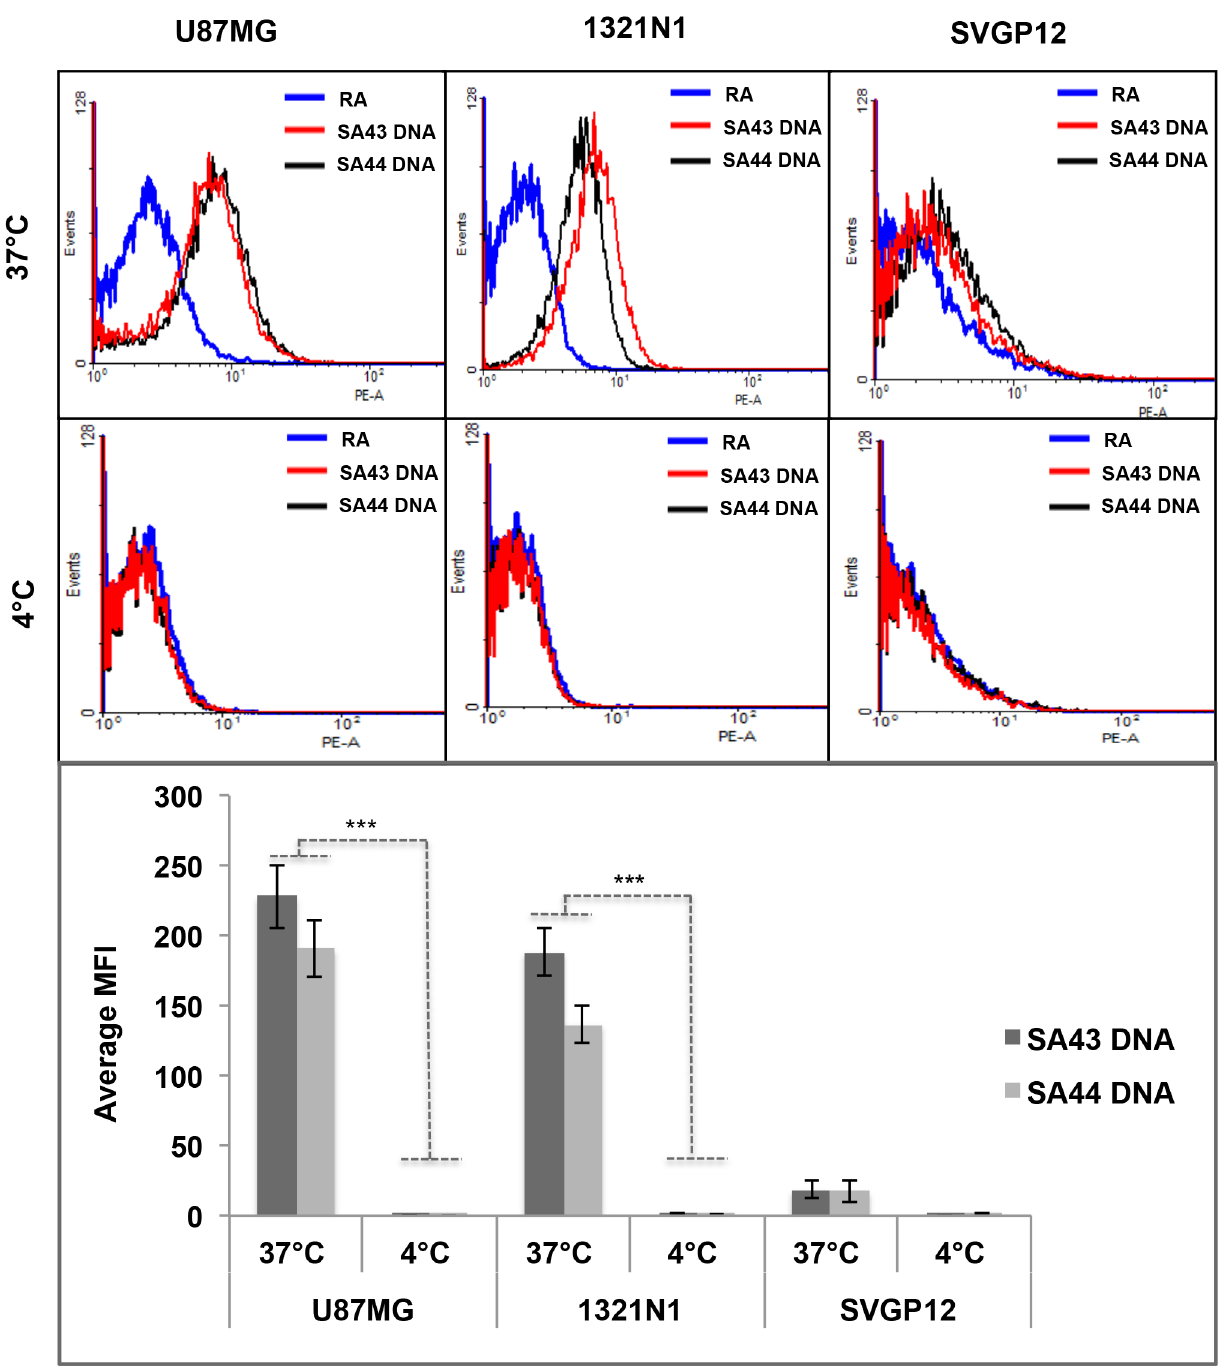
Fig 5. Representative flow cytometry profiles and comparative uptake showing temperature dependent uptake of SA43 and SA44 DNA. Cy3 labelled SA43, SA44 aptamers and random aptamer (RA) (100 nM) were incubated separately with live U87MG, 1321N1 and SVGp12 cells at 37°C (5% CO 2 ) or 4°C for 90 minutes. The blue curve represents the background mean fluorescence intensity (MFI) of the random aptamer. The red and black curve represents the MFI (uptake) of the cells treated with SA43 and SA44 aptamer, respectively. A , B and C represent uptake of SA43 and SA44 aptamers on U87MG, 1321N1, and SVGp12 cells, respectively at 37°C. D , E and F represent negligible uptake of SA43 and SA44 aptamers on U87MG, 1321N1 and SVGp12 cells, respectively at 4°C. G is a bar chart showing comparative uptake of SA43 and SA44 aptamers. The background MFI values for the random aptamer (control) on corresponding cells were subtracted. Statistical significance of the differences in MFI values of SA43 and SA44 aptamers confirm the high uptake by U87MG and 1321N1 cells at 37°C compared to 4°C by a two way ANOVA test ( *** = p < 0.001). All experiments were repeated at least three times. Data are mean of three independent samples; bars,